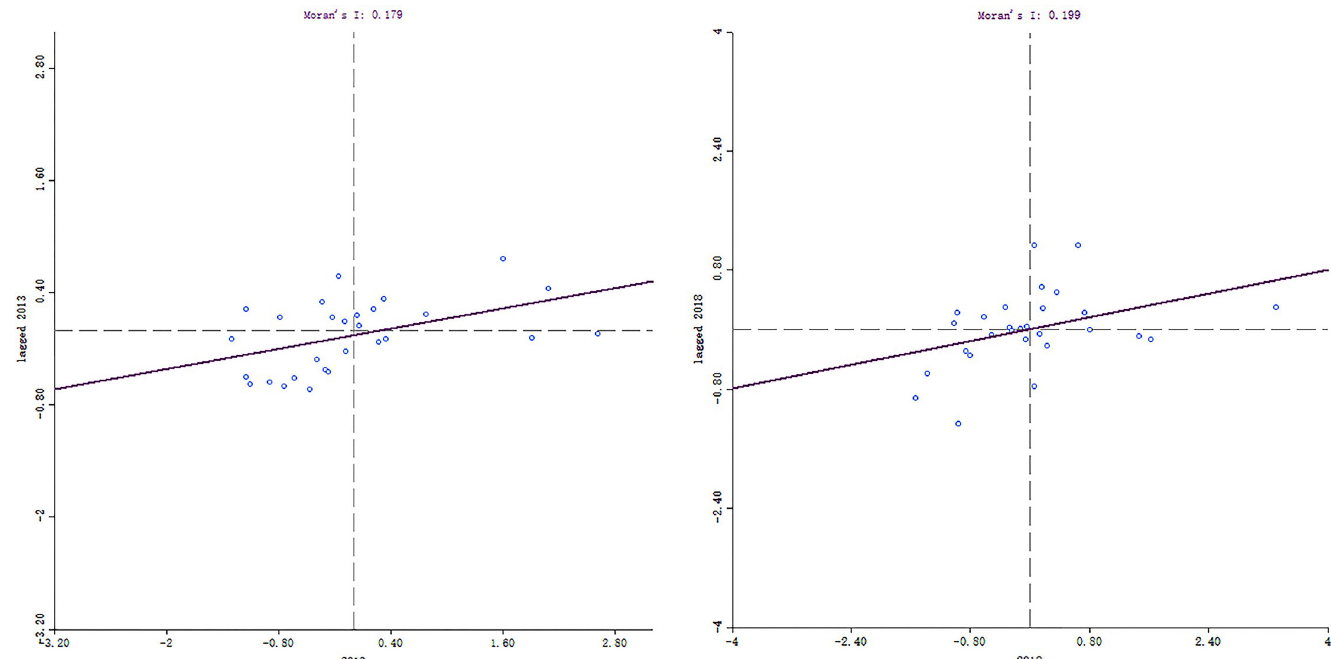
Fig 5. Local Moran scatter diagram of TE in 2013 and 2018.